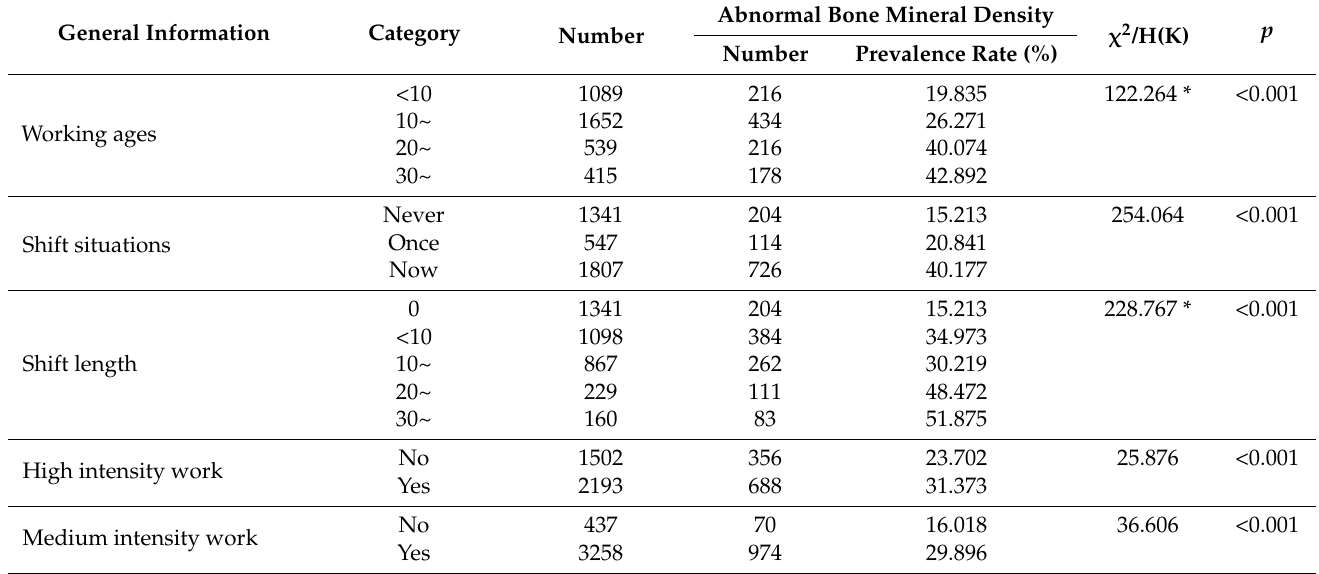
Table 3. Analysis of occupational exposure characteristics of male workers in coal